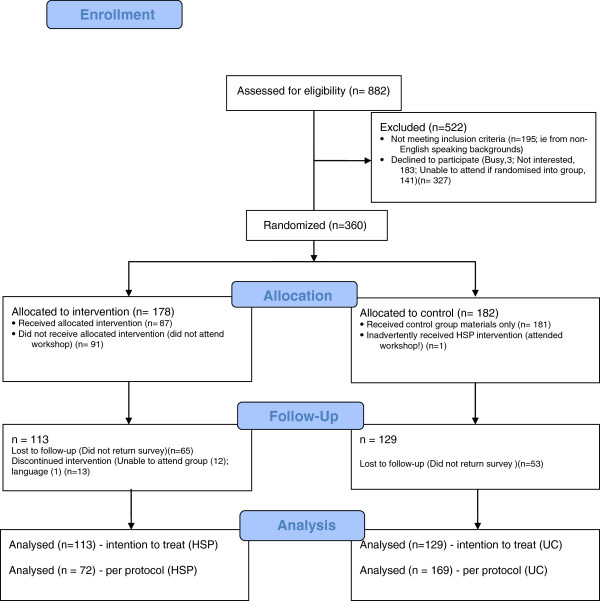
Consort diagram outlining study recruitment and retention.